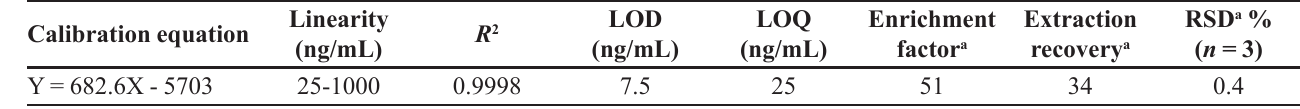
TABLE I - Figures of merit of EME-HPLC-UV analysis for phenobarbital Calibration equation